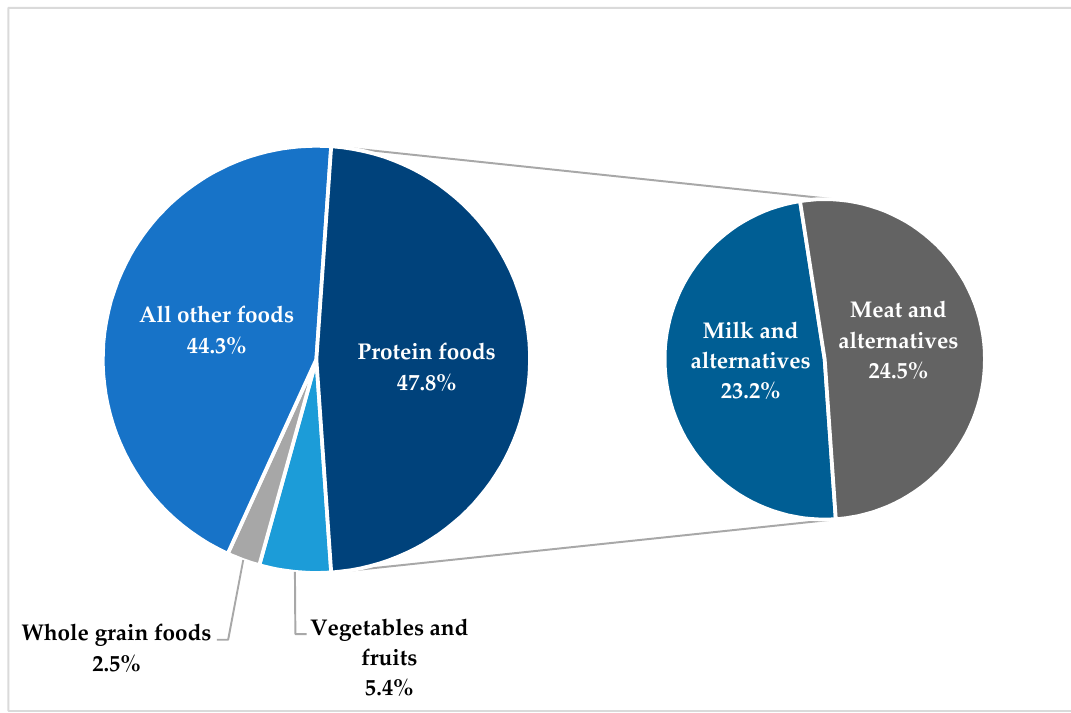
Figure 1. Contribution of 2019 Canada’s Food Guide categories to total SFA intake (in % of total SFA intake).